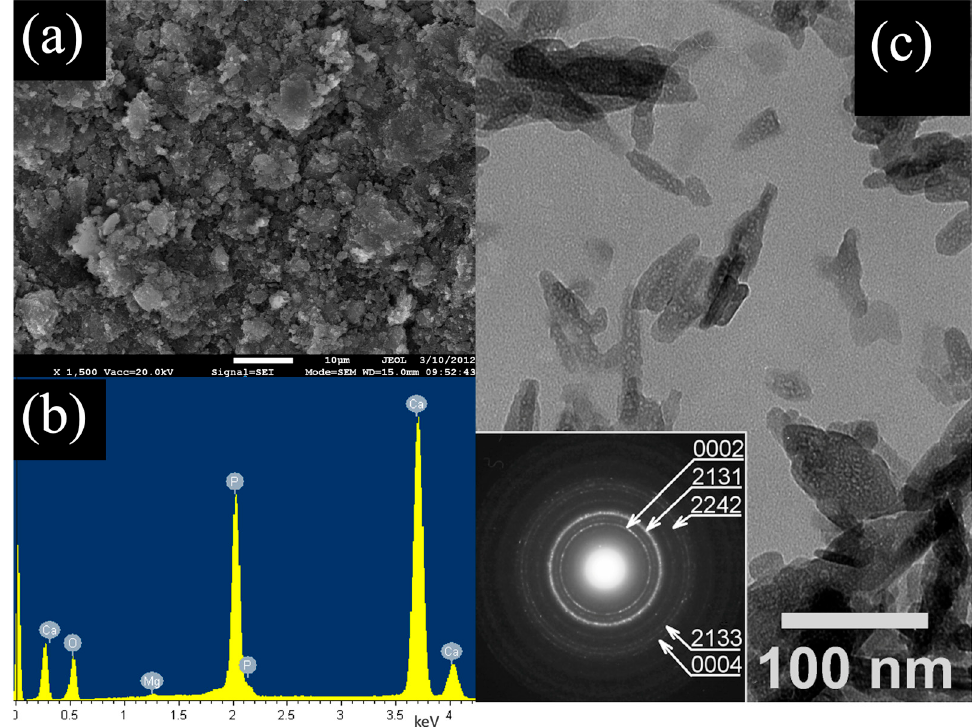
Figure 1. ( a ) SEM micrographs of hydroxyapatite HA, ( b ) EDX spectrum of aggregate consist- ing of hydroxyapatite, ( c ) TEM image of aggregate of hydroxyapatite nanorods in HAwit SAED ring